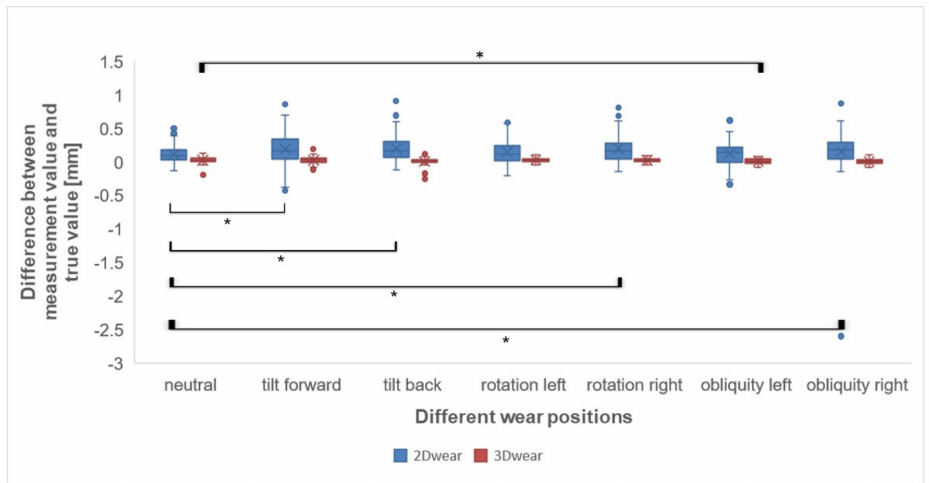
Figure 4. Box plot between 2D wear and 3D wear (the x -axis reveals different wear positions, and the y -axis reveals the difference between the measurement value and true value. The blue and brown boxes illustrate 2D wear and 3D wear , respectively. Stars (*): p <